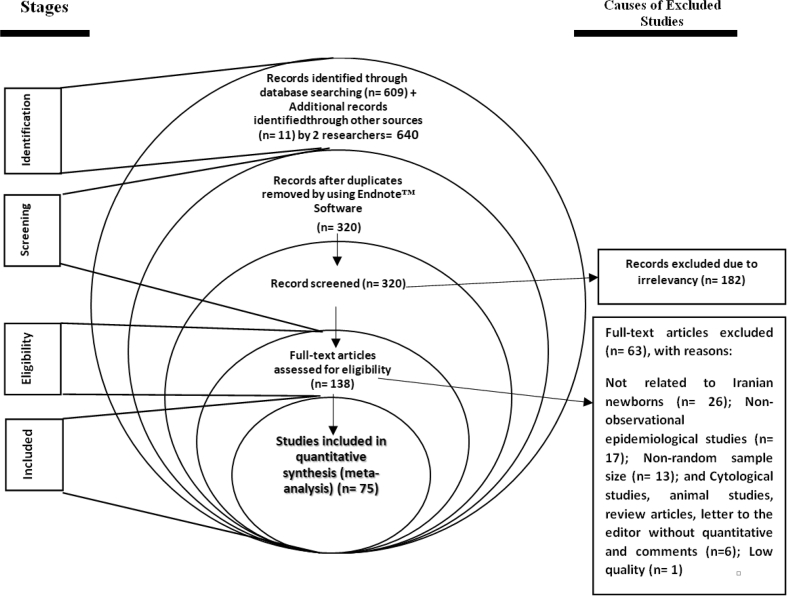
PRISMA flowchart.